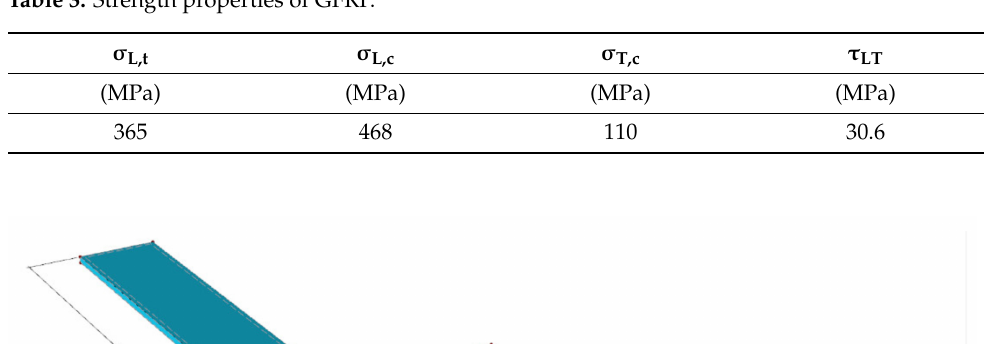
Table 3. Strength properties of GFRP.